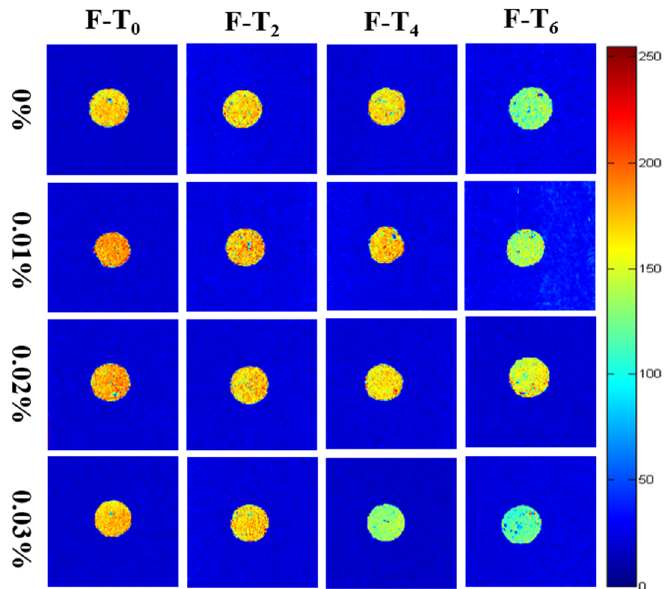
Figure 6. Changes in NMR pseudo color images of surimi gels treated with different content EGCG during F-T cycles. 0%, 0.01%, 0.02%, and 0.03% represented 0%, 0.01%, 0.02%, and 0.03% EGCG content, respectively. Caption: see Figure